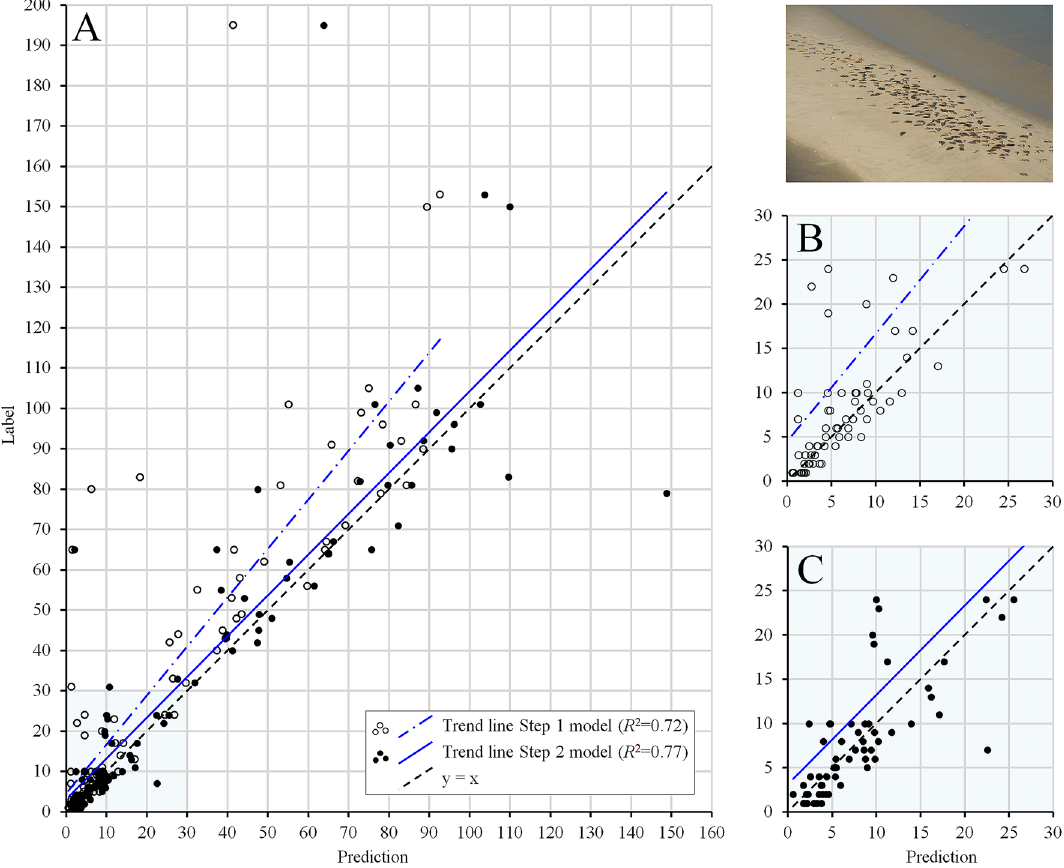
Figure 2. Numerical results on the seal test set ( n = 100 ), where the labels (i.e., the manual counts of hauled out seals) are plotted against the predicted counts. The black dotted lines resemble y = x . ( A ) The accuracy of the model trained on ‘seal subset 1’ (white dots) strongly improved after fine-tuning using training subset 2 (black dots). ( B , C ) Zoomed in (range 0-30) on predicted counts made by the Step 1 model ( B ) and the Step 2 model ( C